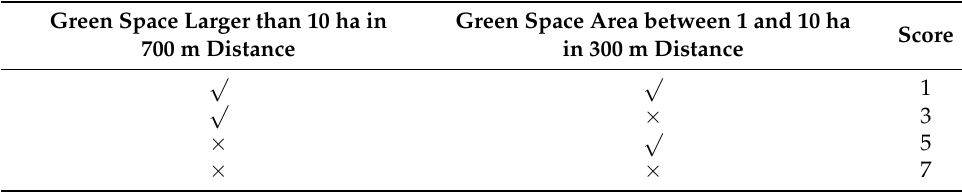
Table 1. Criteria for (mis)match of outdoor recreation supply and